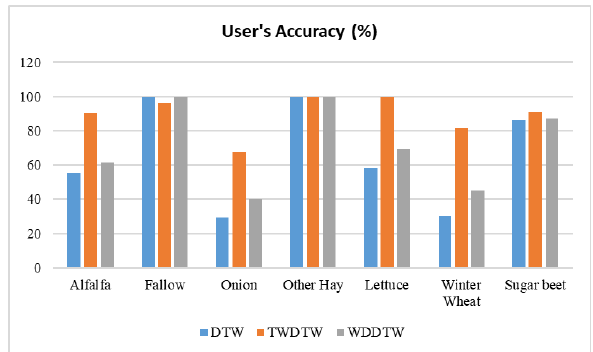
Figure 3. User’s accuracy obtained by applying DTW- Dynamic Time Warping, TWDTW- Time Weighted Dynamic